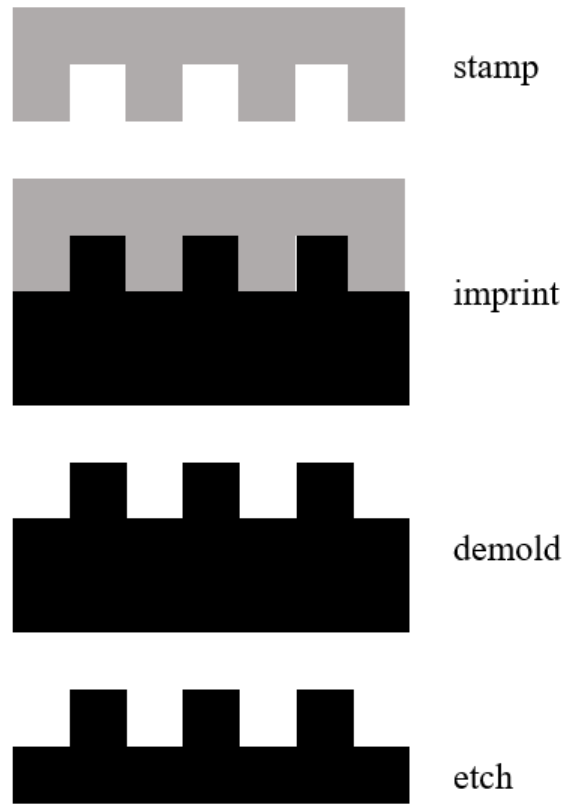
Figure 4. Schematic diagram of the principle of NIL technology.